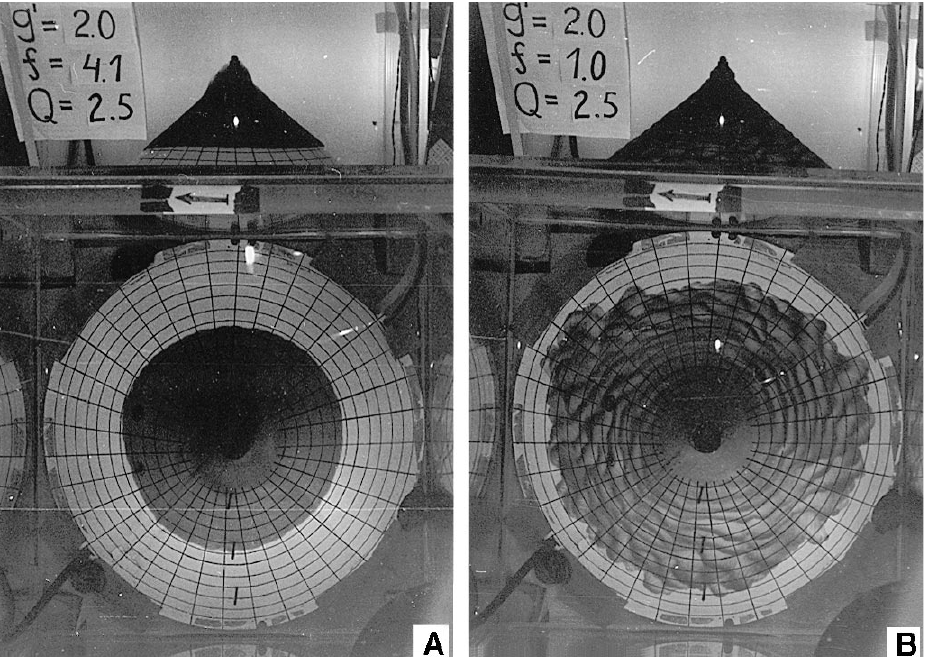
thickness of the bottom